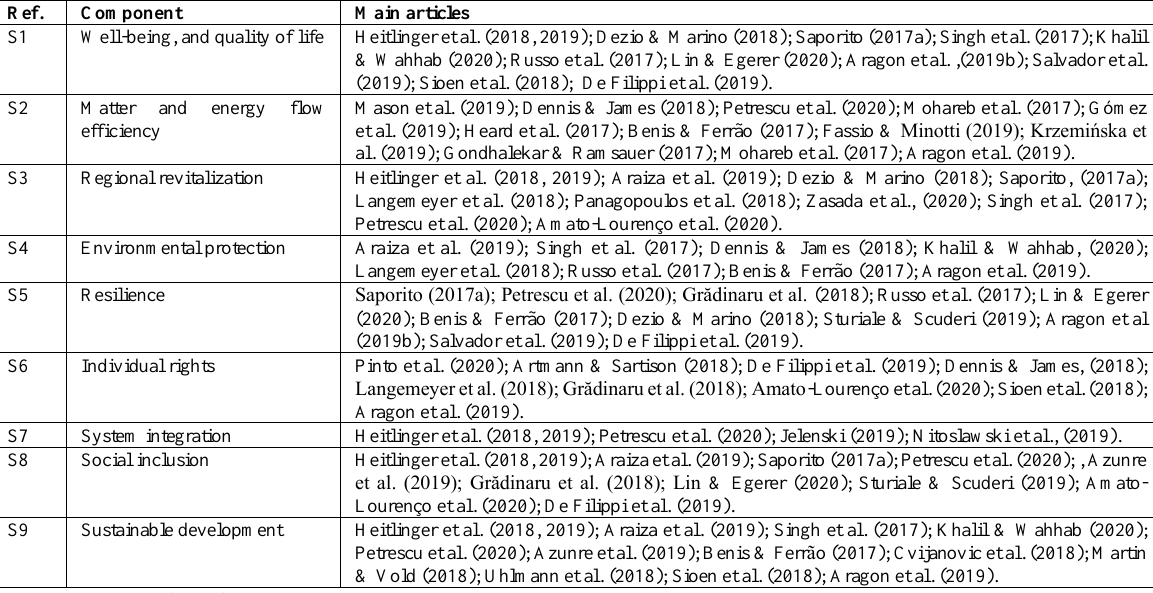
Table 5. Attributes of Society 5.0 and main related articles identified by the systematic literature review. The corresponding codes were used in the relationship matrices.